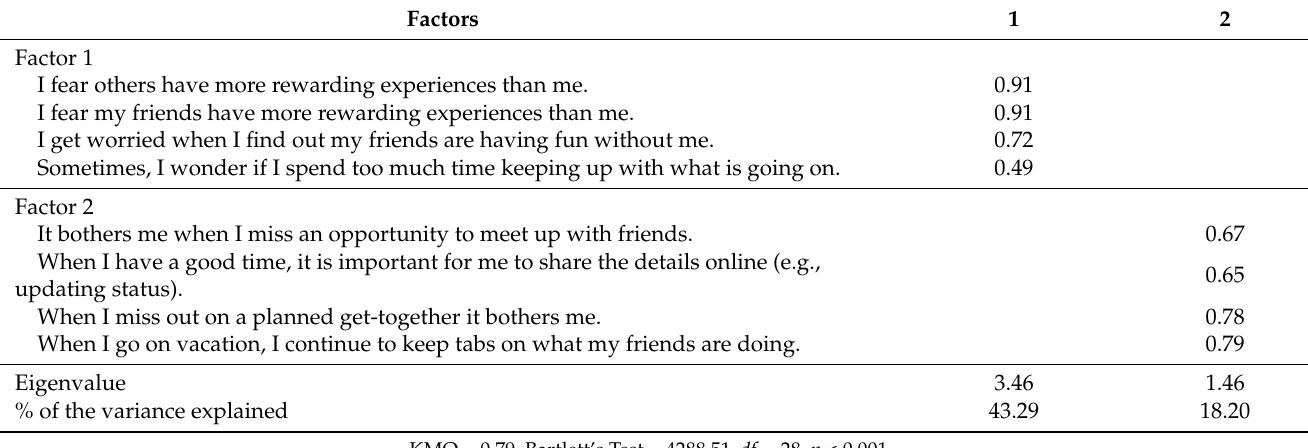
Table 1. Factor analysis of the Fear of Missing Out scale-Chinese version.